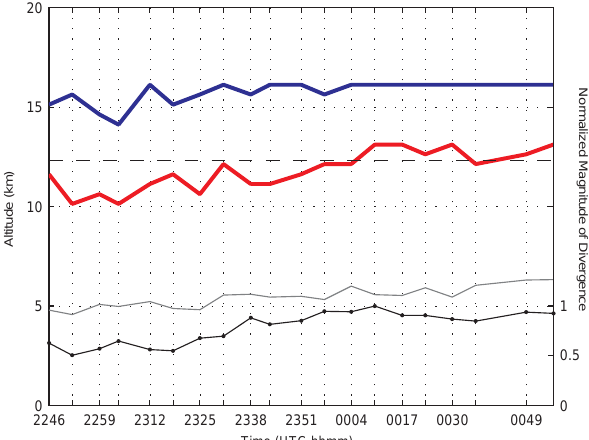
Fig. 3. Left axis: Time evolution of detrainment in 29 June 2000 supercell case including level of maximum detrainment (LMD; red line) and maximum (blue line) and minimum (gray line) extent of detrainment envelope. The altitude of the LNB from the most rep- resentative sounding is shown as a black dashed line. Right axis: Time evolution of normalized detrainment magnitude (black line) for same